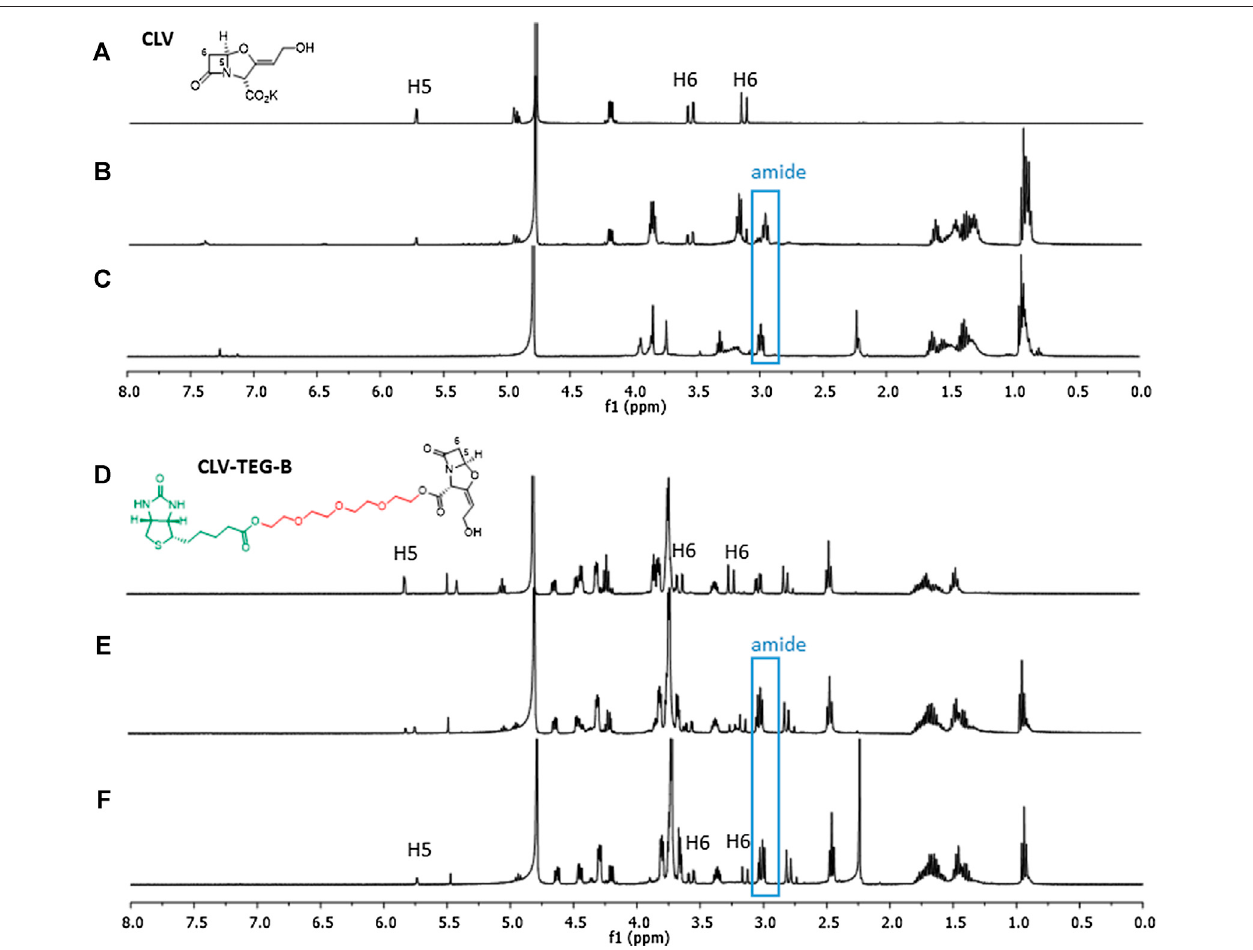
FIGURE 2 | Reactivity of clavulanic acid (CLV) and CLV-tetraethylenglycol-Biotin (CLV-TEG-B). 1 H NMR of each compound at similar conditions: (A) CLV control and (D) CLV-TEG-B control, after 15 min incubation in deuterated PBS. (B) CLV and (E) CLV-TEG-B, incubated with 1 equivalent of butylamine for 15 min (C) CLV and (F) CLV-TEG-B, incubated with 1 equivalent of butylamine for 16 h min. After addition of butylamine is observed amide formation for both compounds.Subsequently,degradationoccursinthecaseofCLVand shifted signalsfor protonscorrespondingto β -lactam(H5and H6)areobservedin the case of